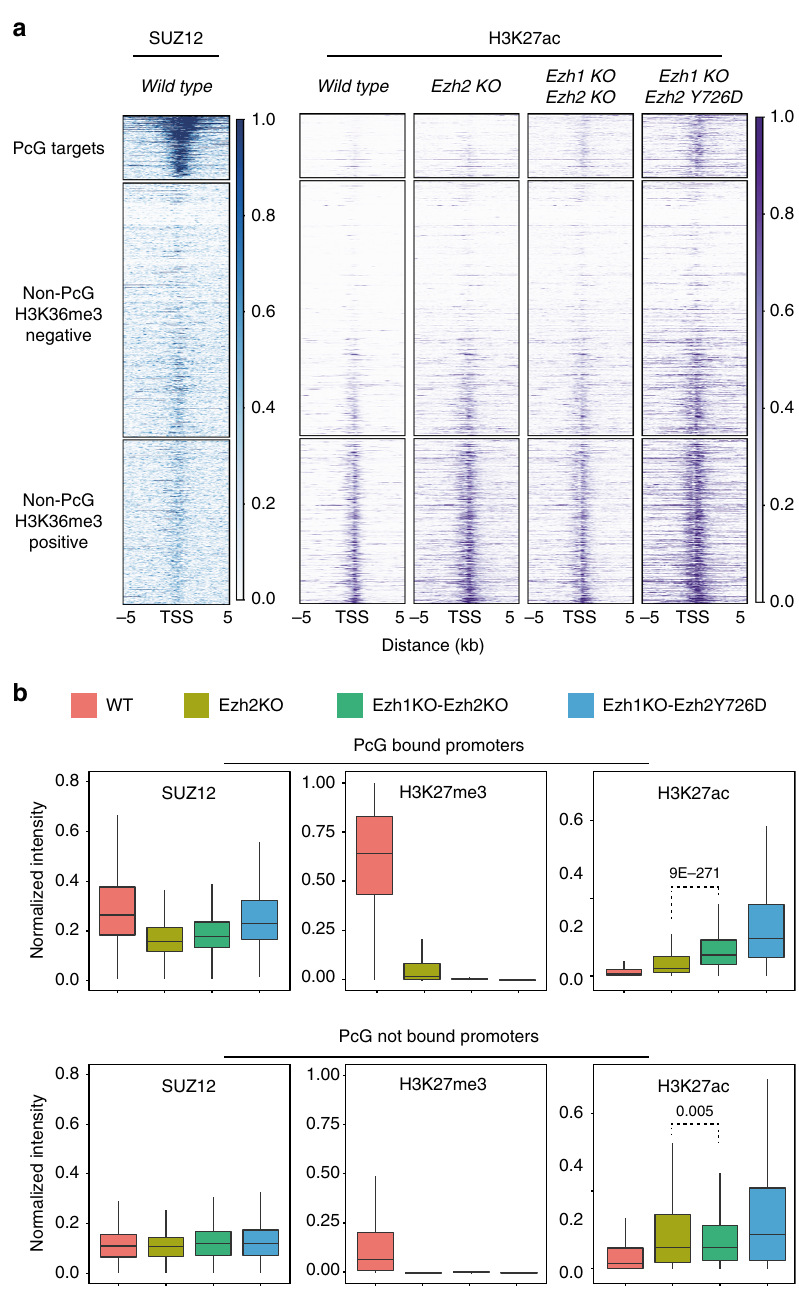
Fig. 6 H3K27me2/3 deposition, but not PRC2 occupancy, prevents H3K27ac invasion at PcG repressed promoters. a Heatmaps representing the normalized SUZ12 and the spike-in normalized H3K27ac ChIP-seq signals ± 5 kb around all TSS annotated in RefSeq. Promoters were clustered into Polycomb targets, H3K36me3 positive and H3K36me3 negative. PcG targets were ranked for the intensity of H3K27me3 deposition while the rest of RefSeq genes for ascending intensity of H3K36me3. b Boxplots representing the normalized intensities of SUZ12 and the spike-in normalized intensities of H3K27me3 and H3K27ac in the indicated cell lines at Polycomb-bound promoters (upper panels) and at Polycomb not-bound promoters (bottom panels). P -values were determined by Wilcoxon